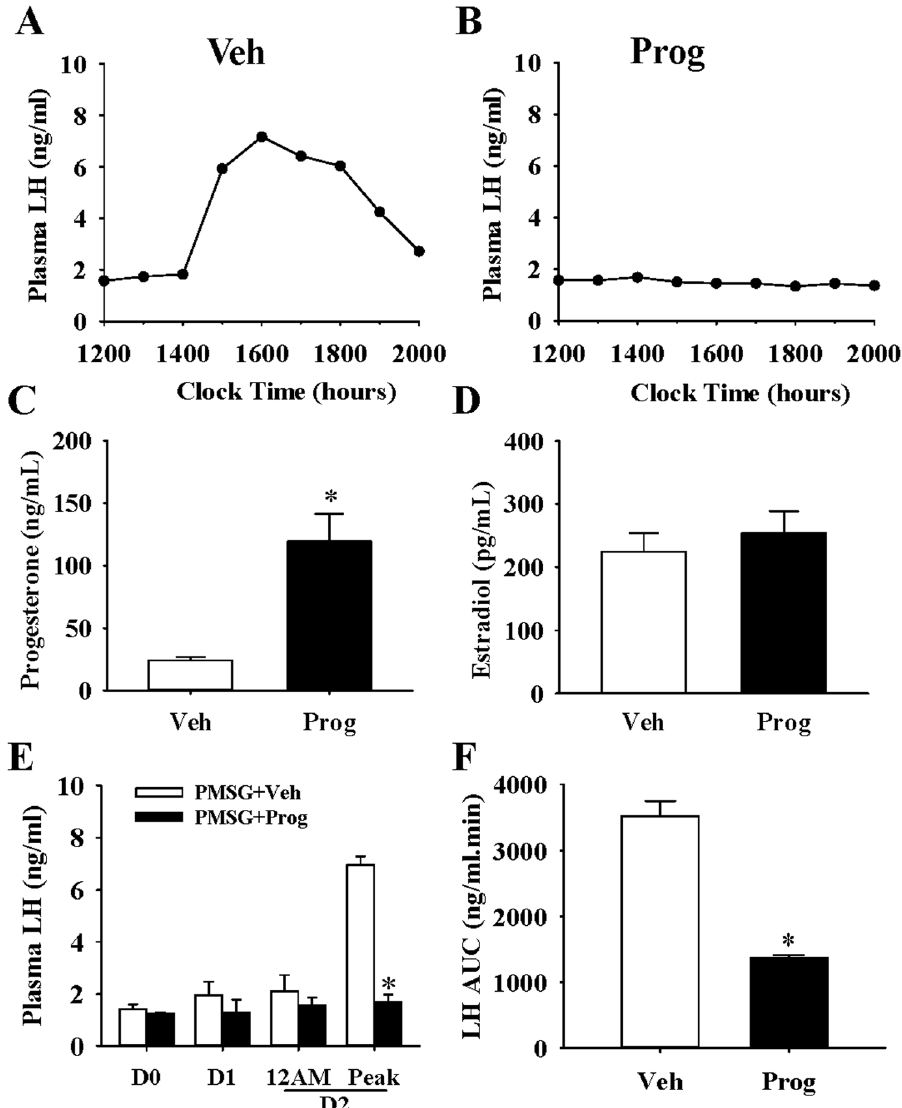
Figure 3. Progesterone disrupted the LH surge in PMSG-primed female rats. Representative examples illustrating levels of LH in oil vehicle (Veh, A ) or progesterone (Prog, B ) treated animals at the expected time of the PMSG-induced LH surge on the afternoon of day 2. ( C ) Mean serum progesterone measured at 18:00 h on day 0 (day 0, PMSG treatment) after injection with vehicle or progesterone in PMSG-primed female rats. ( D ) Mean serum oestradiol level measured at 18:00 h on day 1 (day 0, PMSG treatment) after injection with vehicle or progesterone in PMSG-primed female rats. ( E ) Significant difference in peak LH levels at the time of the expected LH surge between oil controls and progesterone treated PMSG-primed animals. Baseline LH level at noon (12AM) on day 2 showed no difference. ( F ) Area under curve (AUC) analysis of LH levels at the time of the expected LH surge (12:00–20:00 h, day 2) in PMSG-primed female rats treated with oil vehicle or progesterone revealed a significant deference; n = 6 rats/group. Values were analysed by two-way ANOVA with group (Veh vs Prog). Results are presented as means ± SEM. * P < 0.05, Veh vs Prog; n = 5–7 per